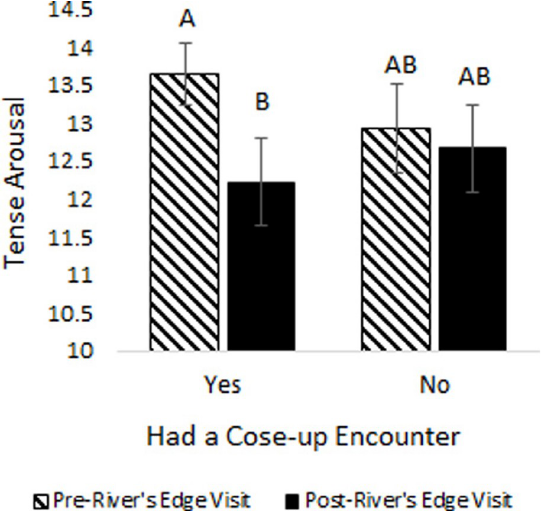
Fig 8. Study participants’ tense arousal (TA) over time by whether or not they had a close-up encounter with the most engaging animal during the River’s Edge experience. Different letters designate significant differences based on the Tukey adjustment for multiple mean comparisons at α =